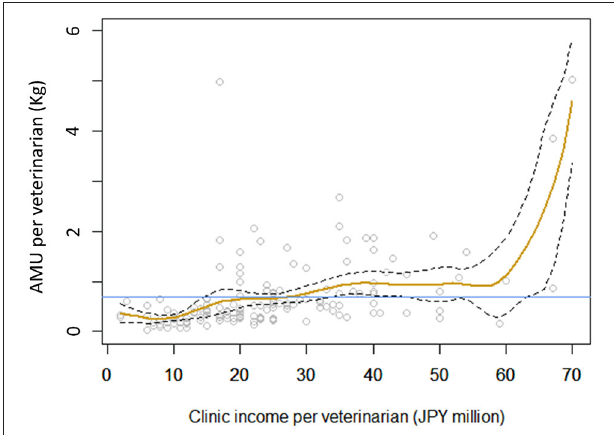
FIGURE 4 | Relationship between clinic income per veterinarian and antimicrobial drug use per veterinarian (in milligrams). Yellow line shows the fitted line, and broken lines show the 95% confidence interval. Blue line shows the mean amount of antimicrobial drugs used among the clinics studied.